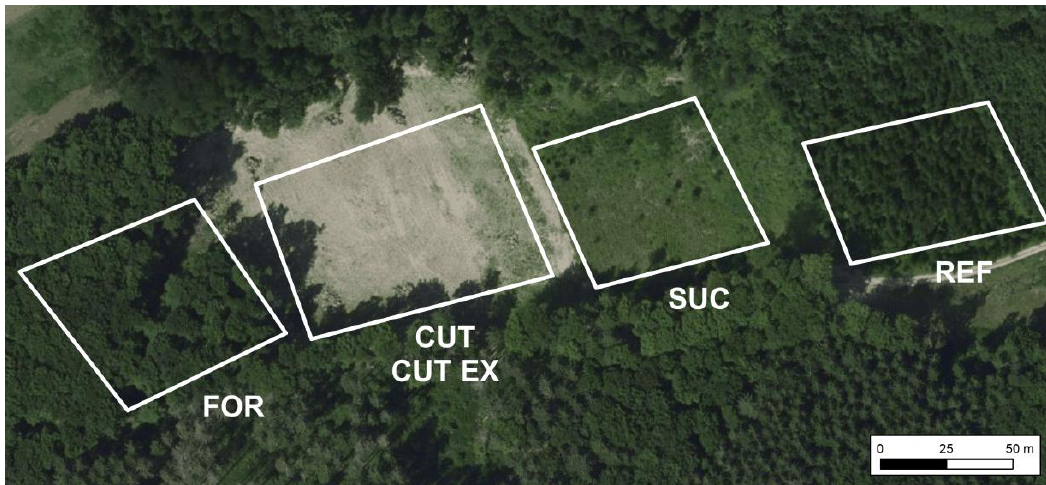
Figure 2. Sampling areas. Aerial photography provided by LVermGeo RLP (2019).